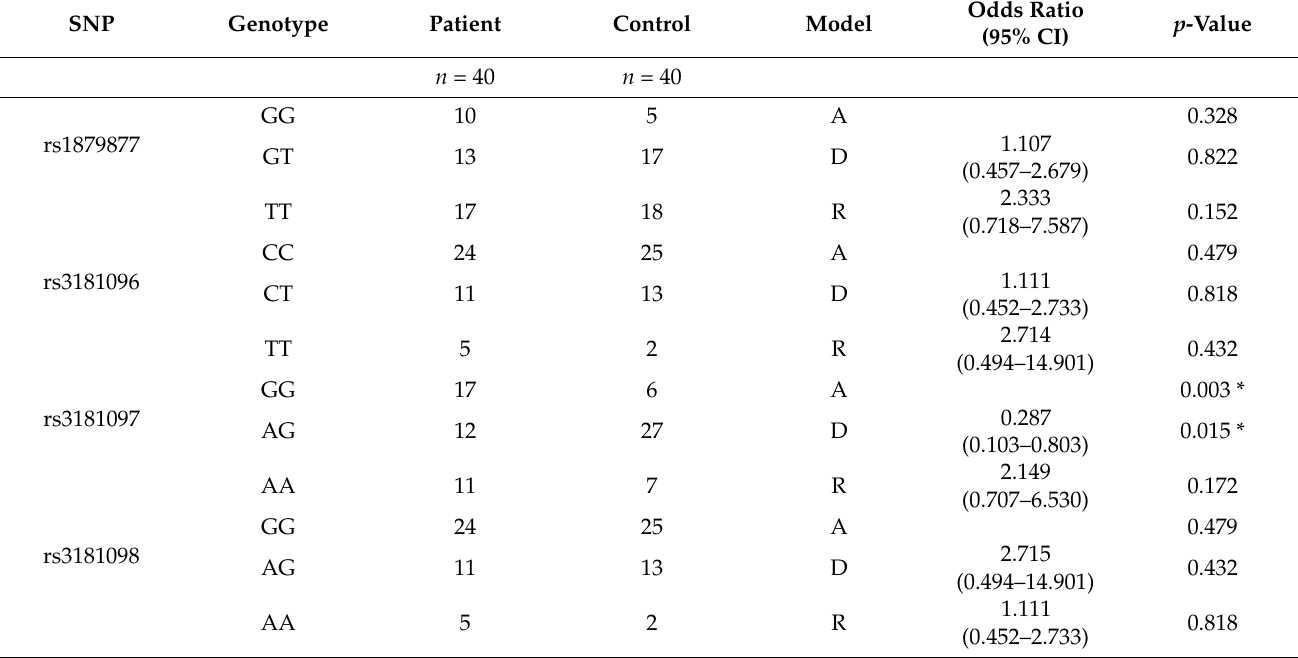
Table 4. Genotypes of CD28 SNPs and their correlations with risk of transfusion